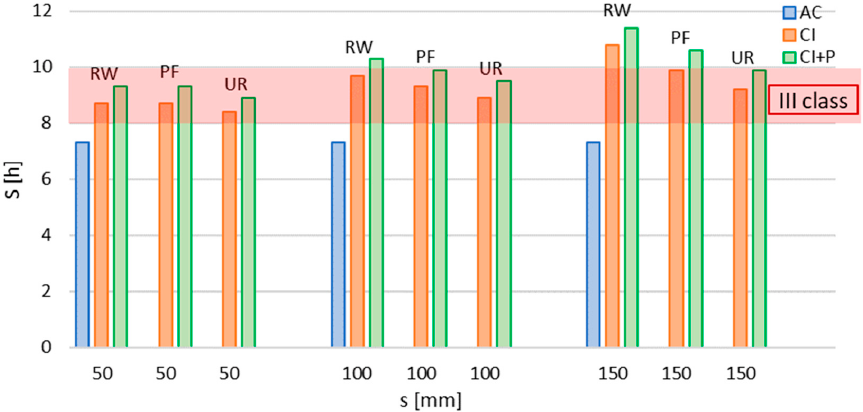
Figure 6. Time shift S.